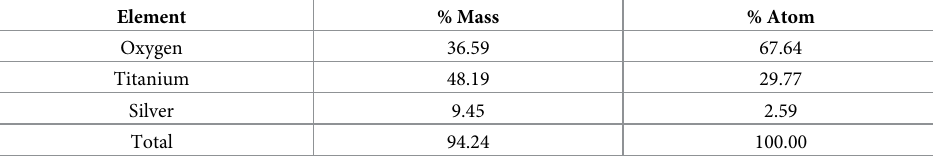
Table 3. Percentage of oxygen, silver and titanium in Ag-TiO 2 samples, obtained by SEM-EDS. Element